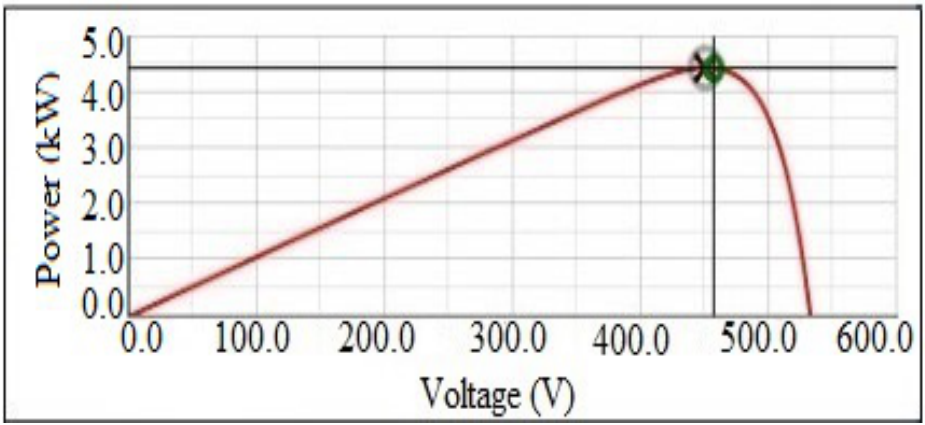
Figure 5. P-V curve for UI